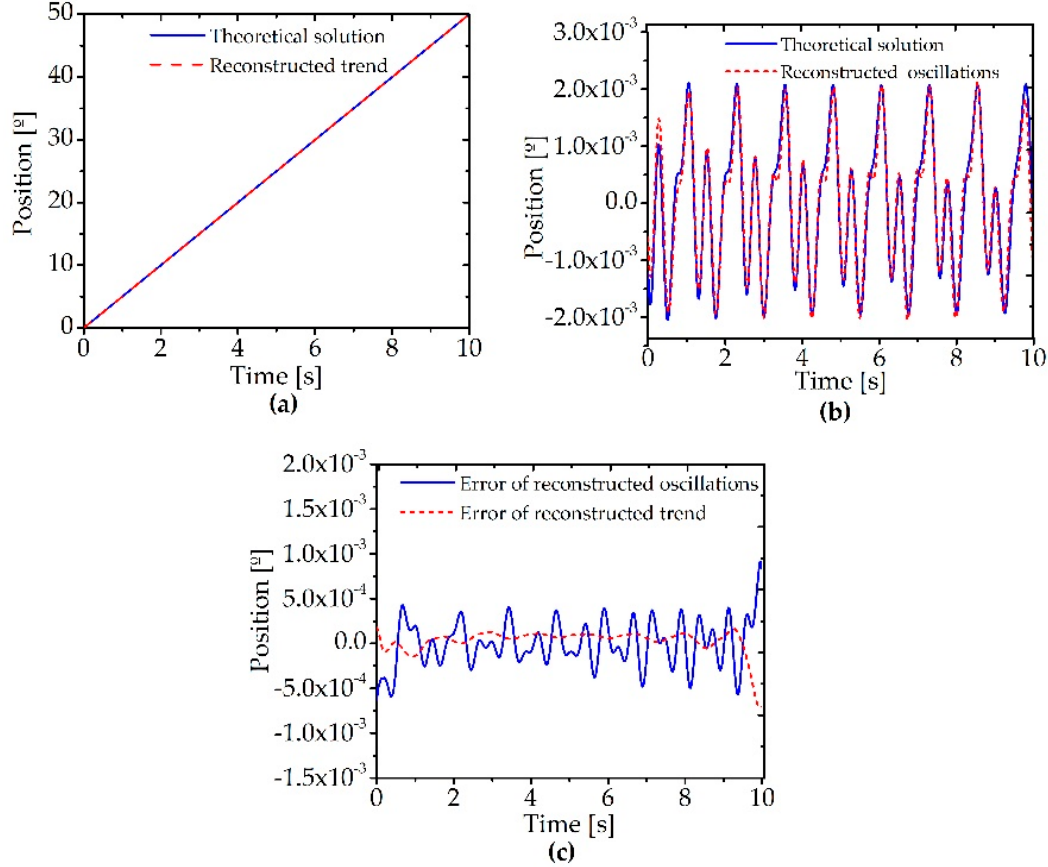
Figure 6. ( a ) Reconstruct trend, ( b ) reconstruct oscillations ( c ) error of rebuilding oscillations and trend via SSA in the simulation.